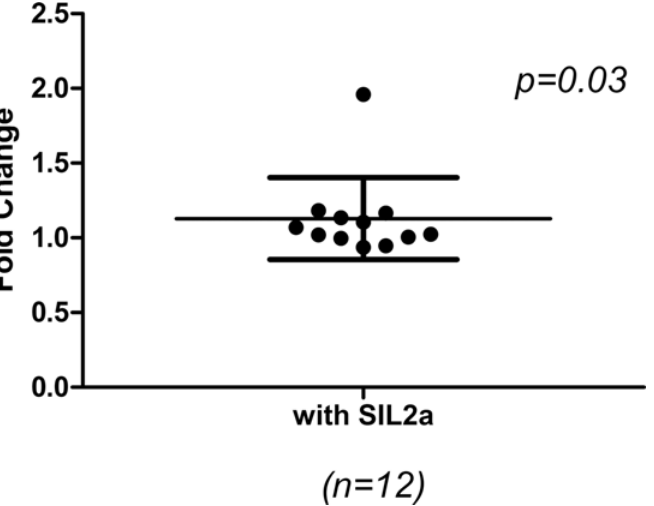
Fig 5. Effects of sIL2R α on the proliferation of CD8 + T cells in the presence of Treg cells. To investigate the effects of sIL2R α on proliferation when CD8 + T cells were co-cultured with Treg cells, CD8 + T cells (10 5 /ml) were co-cultured with CD4 + CD25 + (10 5 /ml) then stimulated with T cell activator CD3CD28 microbeads and sIL2R α (100 ng/ml) 5 – 7 days. Percentage of CFSE dim cells were counted as the proliferation of CD8 + T cells. The results were calculated as the fold-change of the sIL2 α -stimulated over unstimulated cells. sIL2R α induced CD8 + T cell proliferation (median, (interquartile range) of 1.04, (0.99 – 1.15), p = 0.02) when they were co-cultured with Treg cells.